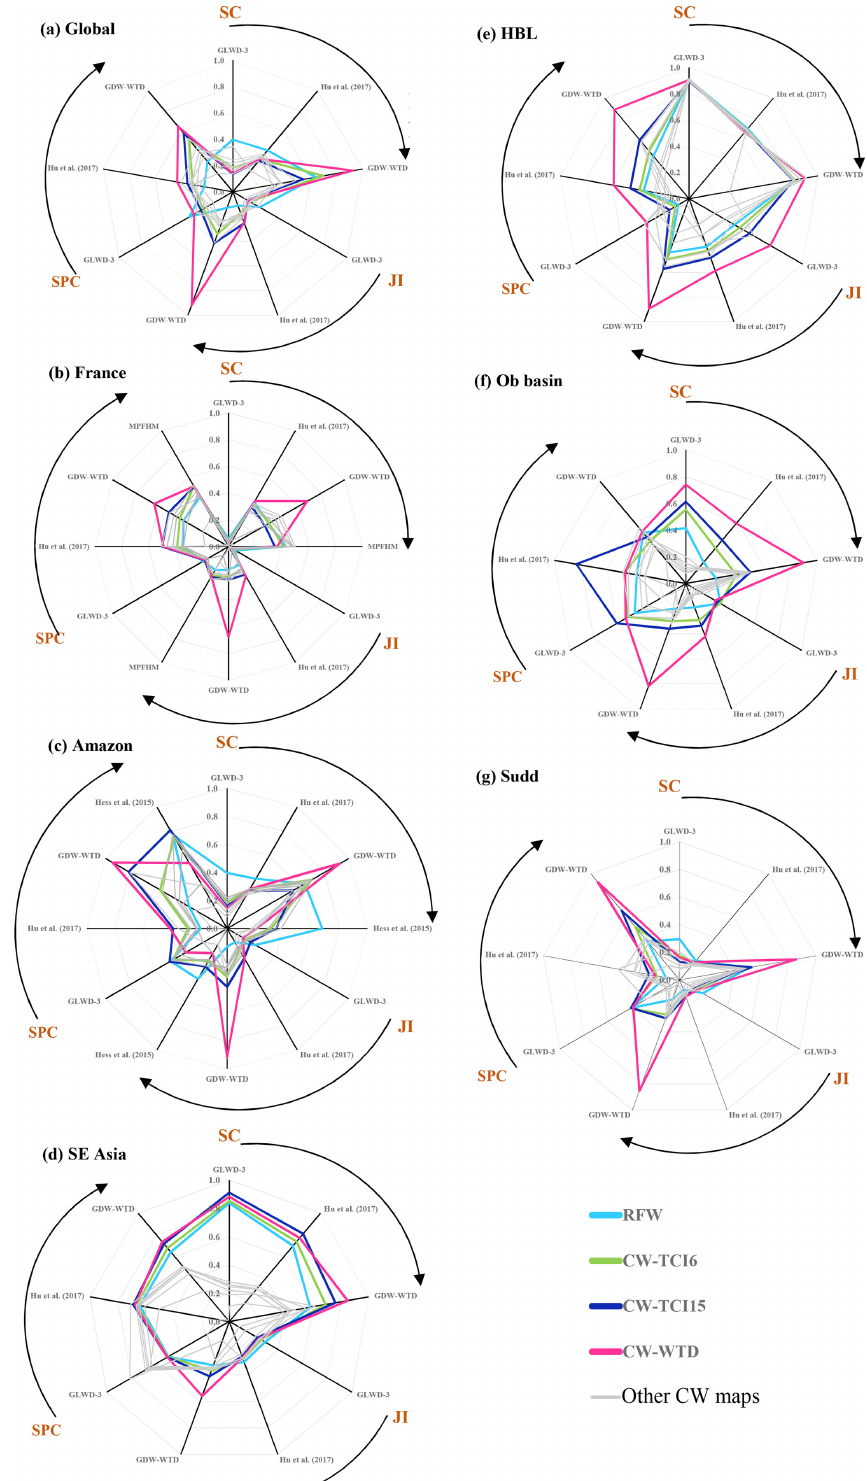
Figure 4. Evaluation criteria between composite wetland maps and evaluation datasets for (a) the global scale, (b) France, (c) the Amazon, (d) Southeast (SE) Asia, (e) Hudson Bay Lowlands (HBL), (f) the Ob basin, (g) the Sudd